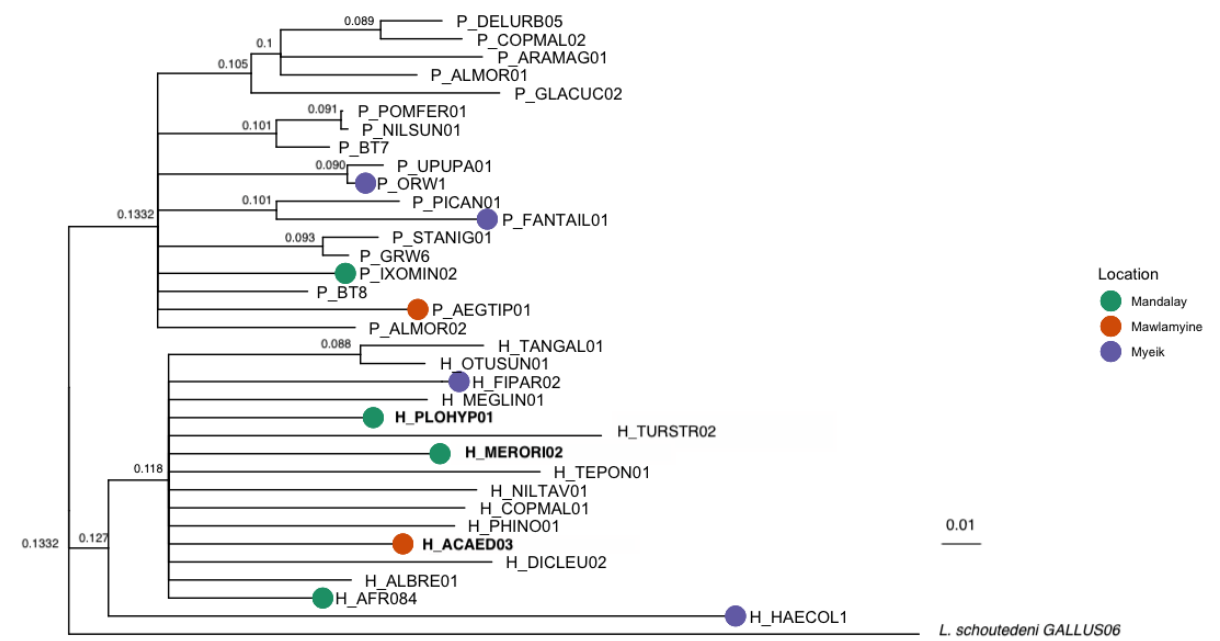
Figure 3. Consensus phylogenetic tree from haemosporidian lineages previously detected in Myanmar [34,35] (no colored dots), and those detected in this study for Mandalay (green dots), Mawlamyine (orange dots) and Myeik (purple dots). Node tips are labelled with abbreviation for parasite genus (H_ = Haemoproteus , and P_ = Plasmodium ), followed by the lineage name. Leucocytozoon schoutedeni (L_GALLUS06, GenBank KM056646) was used as an out-group. New lineages (sequences not previously published in GenBank) are indicated in bold.